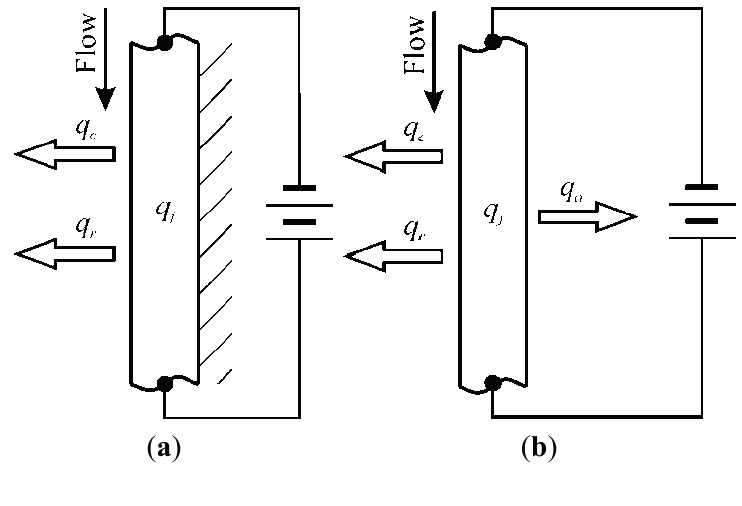
Figure 1. Sketch of the heated thin foil sensor: ( a ) adiabatic back surface; ( b ) diabatic back